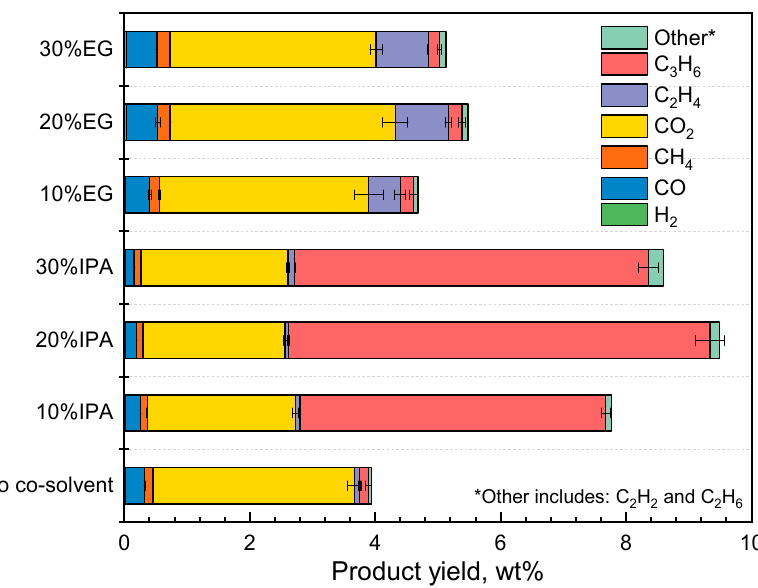
Figure 8. Gaseous products compositions and yields from HTL treatment of Tetraselmis sp. at 350 °C for 30 min, with varying co-solvent concentration (IPA: Isopropyl alcohol; EG: Ethylene glycol). Error bars represent standard deviations from duplicate experiments.